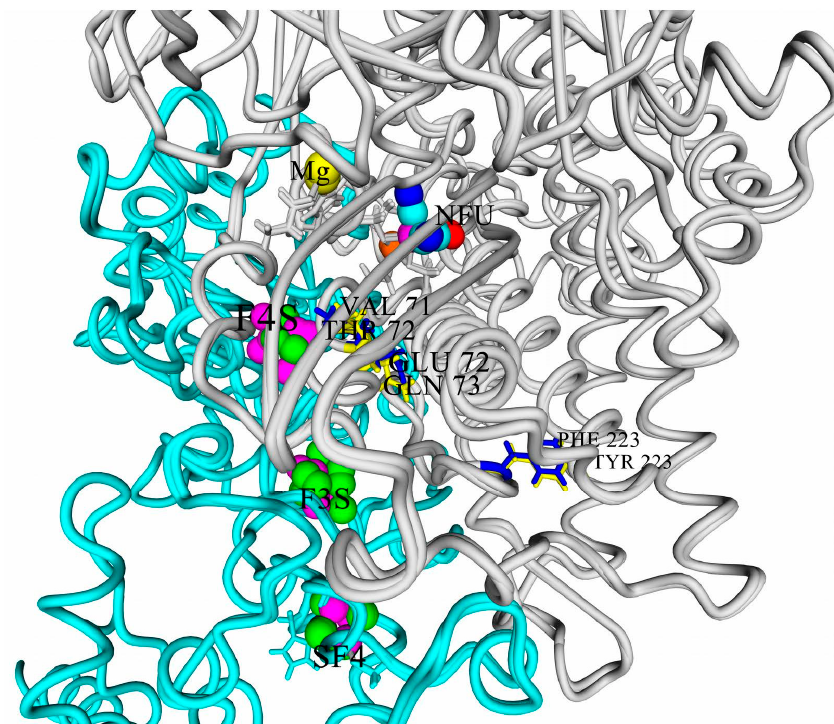
Figure 3. Microenvironment of the clusters of the studied hydrogenases: superposition of hydrogenases from Rps. palustris and from Rvi. gelatinosus . Most of the atoms of the active site (NFU) and FeS clusters are colored by YASARA element coloring scheme: iron, magenta; sulfur, green; carbon, cyan; oxygen, red; and nitrogen, blue. The nickel atom is colored orange, and the magnesium atom (Mg) is yellow. The large subunits are colored gray, the small subunits are cyan, the residues specific for “oxygen-tolerant” hydrogenases are colored blue (in HupSL from Rvi. gelatinosus ), and the ones specific for “oxygen-sensitive” enzymes are shown in yellow (in HupSL from Rps. Palustris ). F4S-proximal 4Fe3S cluster; F3S-medial 3Fe4S cluster; SF4-distal 4Fe4S cluster.